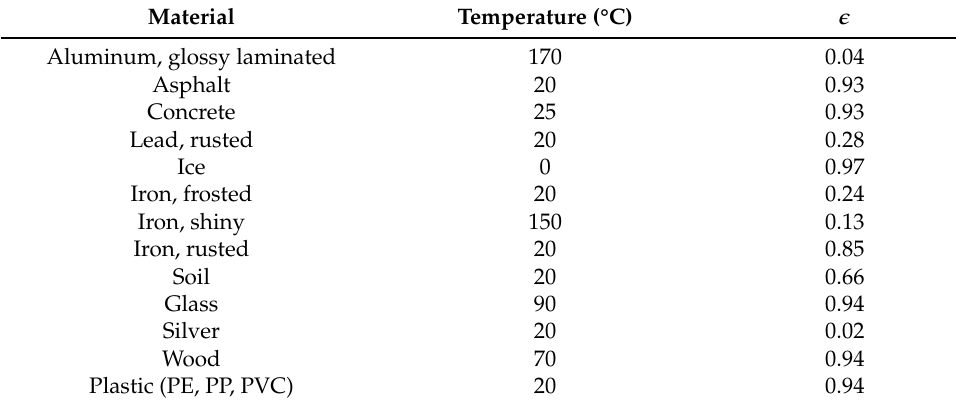
Table 2. Elements and components of the mobile platform [35,36].